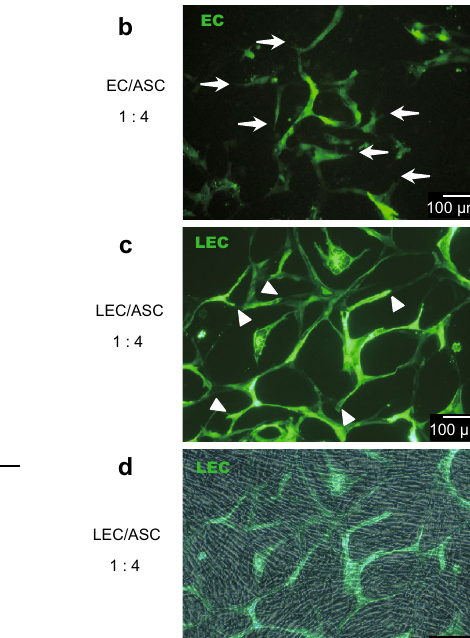
pattern by LECs, whereas altering the LEC/ASC ratio from 1:4 to 3:2 appeared to promote the formation of ‘islands’ containing dense mesh pattern of LECs (Fig. 2a–l). Quantitative evaluations revealed that VEGF-C con- centration had no significant effect on the number of branches per mm 2 (Fig. 2m) or the branch length per mm 2 (Fig. 2n). However, changing the LEC/ASC ratio from 1:4 to 3:2 was associated with more branches per mm 2 (P < 0.05, two-way ANOVA, Fig. 2m) and a longer branch length per mm 2 (P < 0.05, two-way ANOVA, Fig. 2n). Pairwise comparisons showed that branch density in the 3:2 ratio/25 ng/mL VEGF-C group was significantly higher than that in the 1:4 ratio/0 ng/mL VEGF-C group or the 1:4 ratio/25 ng/mL VEGF-C group (P < 0.05). Lymphatic vessel-like structures were evident in a three-layered LEC/ASC cell sheet (1:4 ratio) 2 weeks after transplantation onto rat gluteal muscle. To explore whether lymphatic vessels would develop in LEC/ASC sheets after transplantation in vivo, three LEC/ASC sheets (1:4 ratio) were stacked (Fig. 3c) and transplanted onto rat gluteal muscle. It is a first stage proof-of-concept to confirm LEC/ASC sheets can organize lymphatic vessel-like structures in vivo. Immunostaining of the cell sheets/underlying gluteal muscle for podoplanin 2 weeks after transplantation revealed the presence of vessel-like structures composed of LECs (Fig. 3c), and high-power images confirmed that corpuscles had migrated within the cell sheets (Fig. 3d). Devel- opment of lymphatic vessel-like structures by cell sheet transplantation were observed. Comparison of LEC-derived lymphatic vessels between different methods of cell transplanta- tion onto rat gluteal muscle. In the next series of experiments, we compared three different methods of cell transplantation onto rat gluteal muscle: injection of a suspension of LECs and ASCs at a 1:4 ratio (cell suspension group, Fig. 4a); transplantation of three stacked LEC/ASC (1:4 ratio) sheets (diffuse LEC network group, Fig. 4b); and transplantation of two ASC sheets stacked together with one LEC/ASC (3:2 ratio) sheet (localized LEC network group, Fig. 4c). Immunostaining for human podoplanin was used to identify lymphatic vessel-like structures derived from the transplanted LECs (Fig. 4d–f), and the characteristics of the lymphatic vessels derived from the transplanted LECs were quantified (Fig. 4g–j). The cell suspension group contained a larger number of host vessels (i.e., arterial, venous and lymphatic vessels of host that were negative for anti- human podoplanin antibody) in the subcutaneous layer than the cell sheet groups, which may have been due